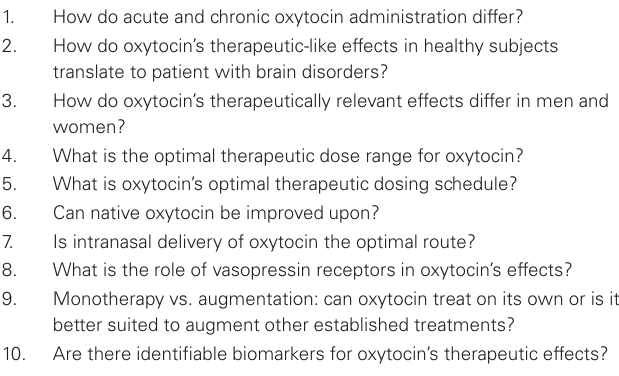
Table 2 | Ten questions for the development of oxytocin-targeted therapeutics for brain